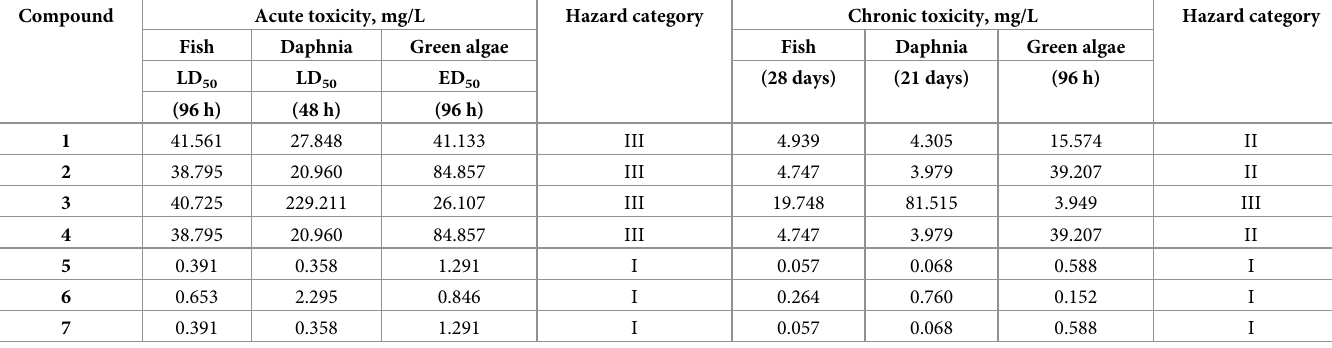
Compound numbers are presented according to Fig 4. The calculation of chronic toxicity is the geometric mean of the concentration leading to no visible effects (NOEC) and of the observed lowest effective concentration (LOEC). LD 50 –the average lethal dose, ED 50 –the average effective dose. I–highly toxic, II–toxic, III– dangerous for aquatic organisms, IV–non-toxic [91].